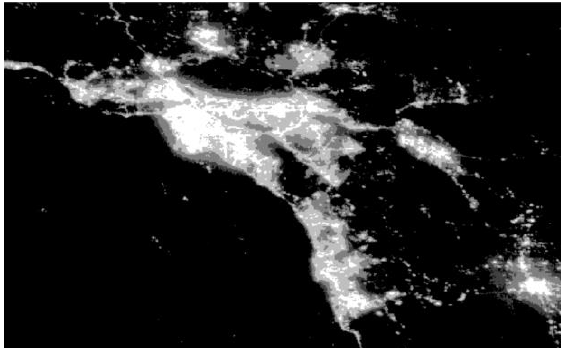
Figure 9. Megalopolis of Los Angeles - San Diego -Tijuana